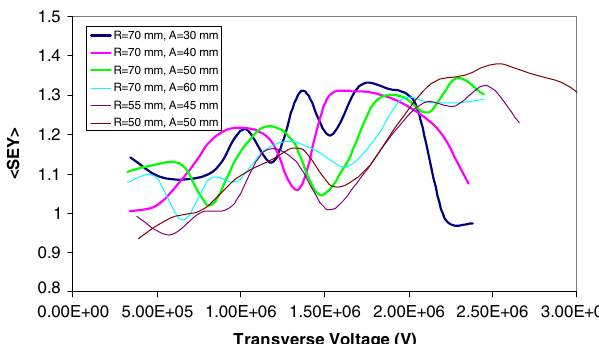
FIG. 15. Maximum h SEY i ; as a function of transverse voltage from CST PARTICLE STUDIO for various 800 MHz cavity geome- tries. The iris radius, R , and the iris rounding, A , are given for each